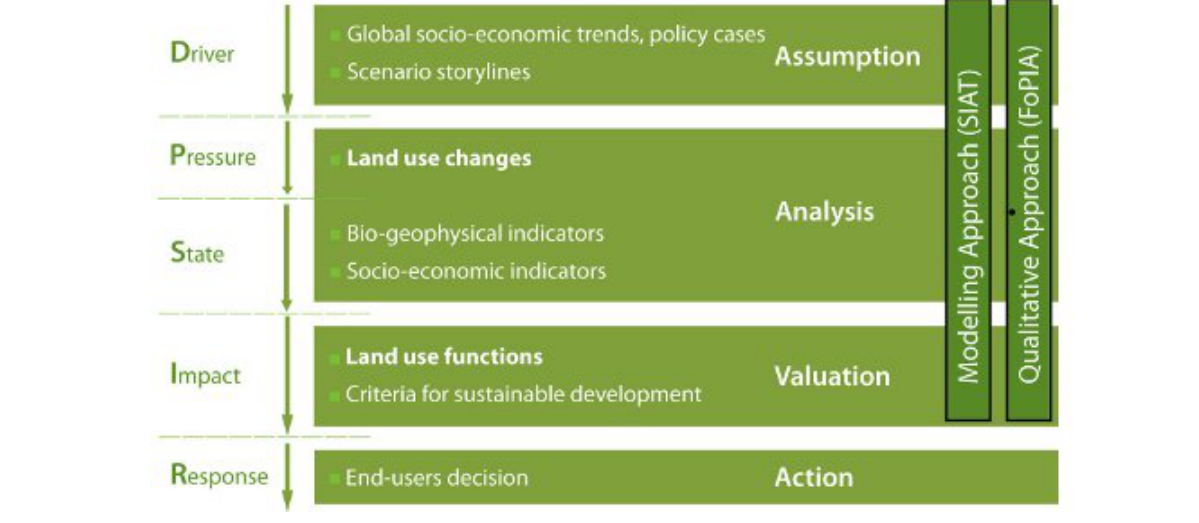
Fig. 1 . Illustration of the integrated framework for policy impact assessment, as described in Helming et al.